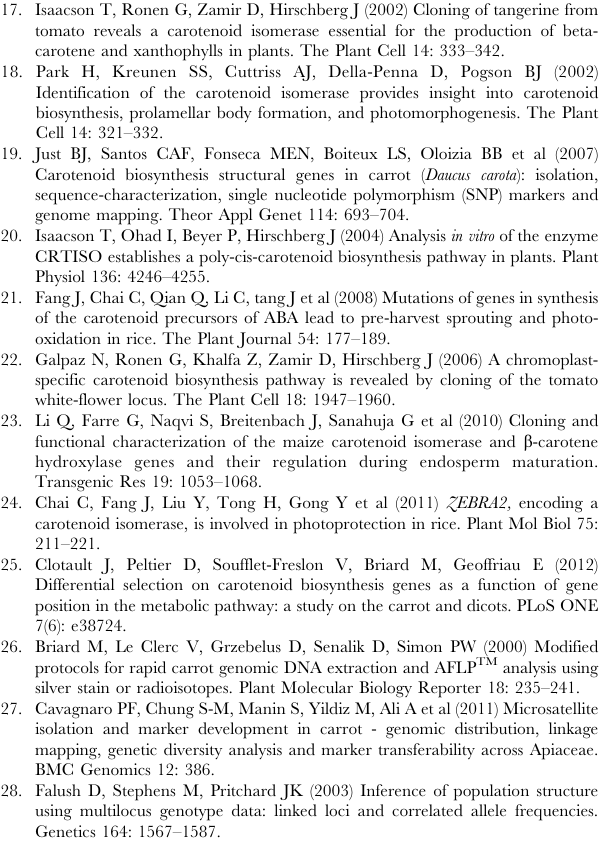
Figure S2 Genetic structure of 39 carrot cultivars based on a correspondence analysis (CA) on microsatellite data. Squares and circles represent respectively individuals from the Western genetic group and individuals from the Eastern genetic group according to STRUCTURE results. Figure S3 Significance of Tajima’s D according to the genetic bottleneck severity k , for (A) the total sequence, (B) the coding sequence and (C) the non-coding sequence. Ten values of bottleneck severity from 0.2 (most severe) to 50 (least severe) were tested. The significance was